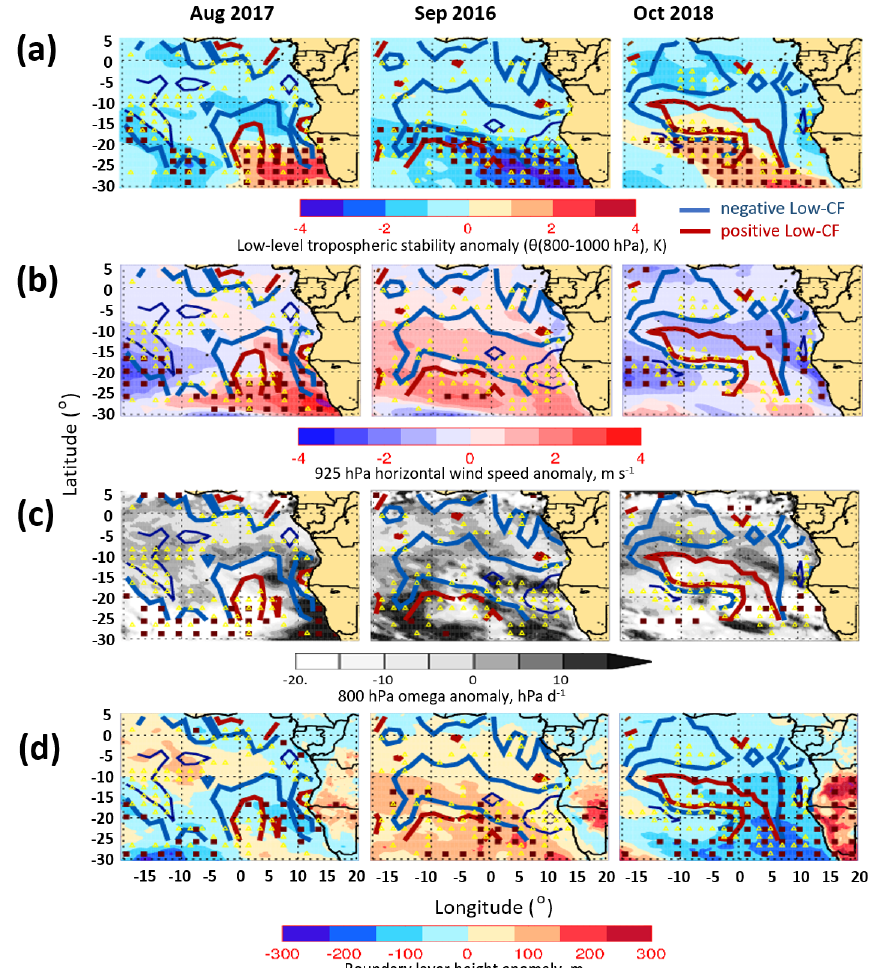
Figure 8. Maps of (a) LTS anomaly (shading; Kelvin). (b) The 925hPa horizontal wind speed anomaly (shading; ms − 1 ), (c) 800hPa vertical velocity anomaly (omega; gray shading; subsidence is a positive value; hPad − 1 ), and (d) BLH anomaly (shading; meters) for the deployment months (August 2017, September 2016, and October 2018). All maps are overlain by a low-CF anomaly (contours, from thick to thin, in blue ( − 0.02, − 0.07, and − 0.12) and dark red ( + 0.02, + 0.07, and + 0.12); percent), which is smoothed by averaging at 2 ◦ (longitude) by 5 ◦ (latitude) to reduce the noise. The purple square (yellow triangle) indicates that the shaded field (low-CF anomaly) data are significant at the 85% confidence